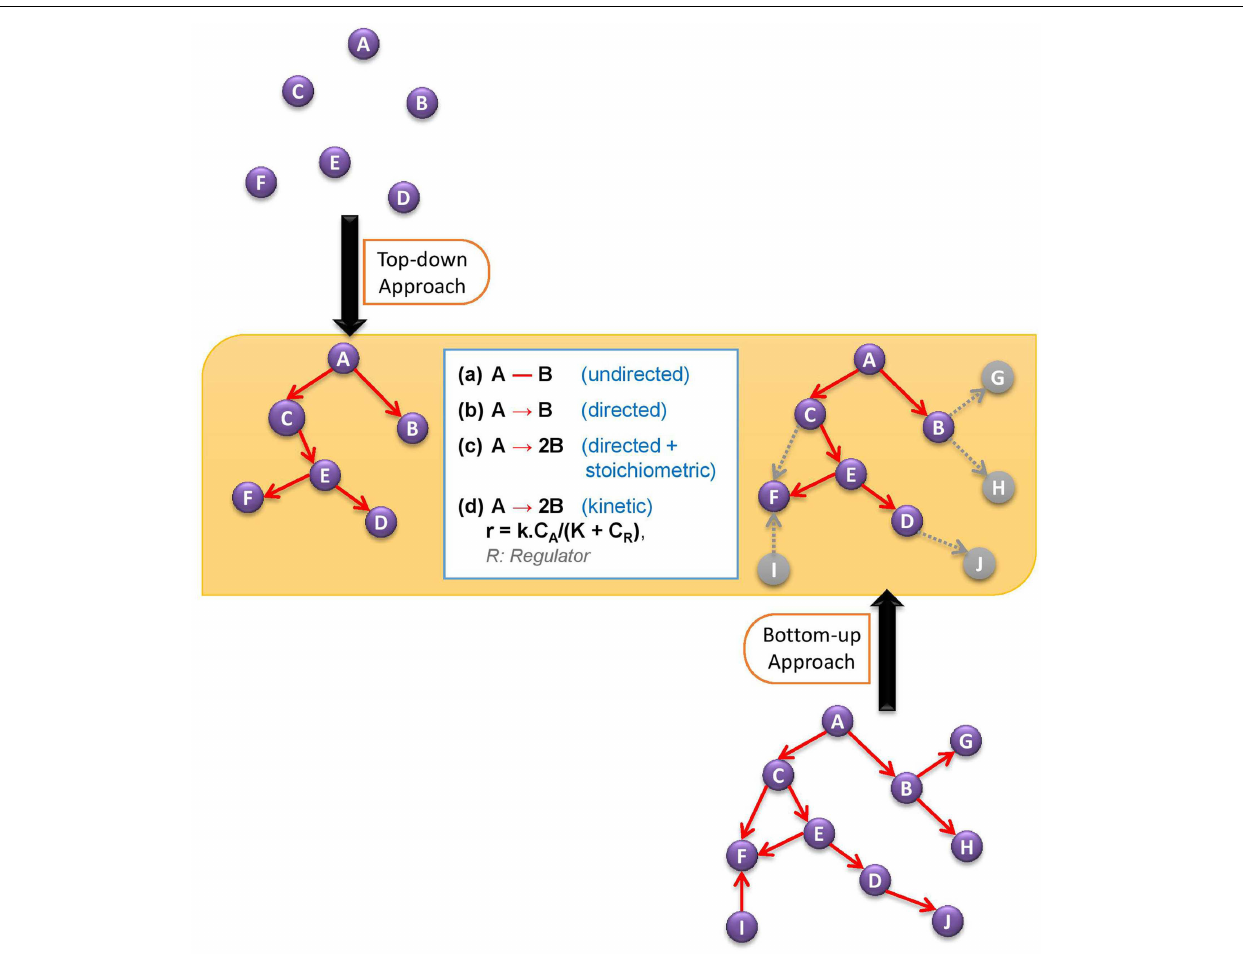
network structure. Figure 1 illustrates the two alternative network discovery